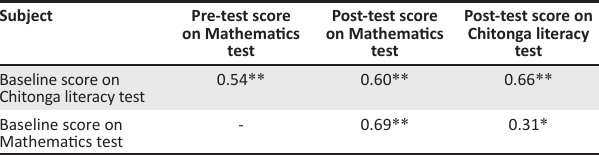
TABLE 5: Pearson product-moment correlation coefficients (r) amongst test were computed. The mean scores for home–school scores by learners in the control group at pre- and post-test stages. Subject Pre-test score Post-test score Post-test score on on Mathematics on Mathematics Chitonga literacy test test test Baseline score on Chitonga literacy